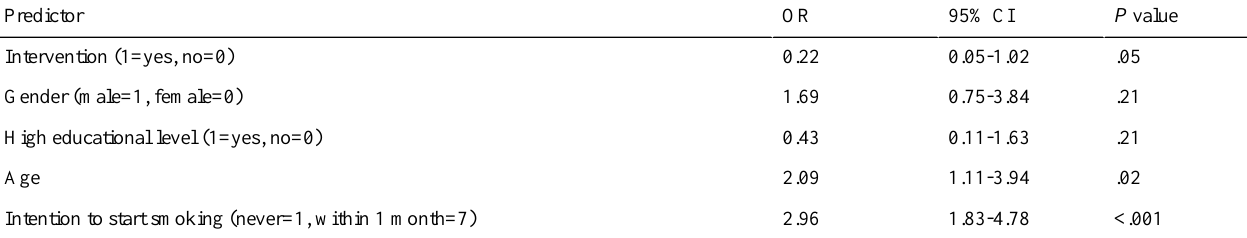
Table 4. Predictors of smoking initiation at 6-month follow-up for students aged 14-16 years.